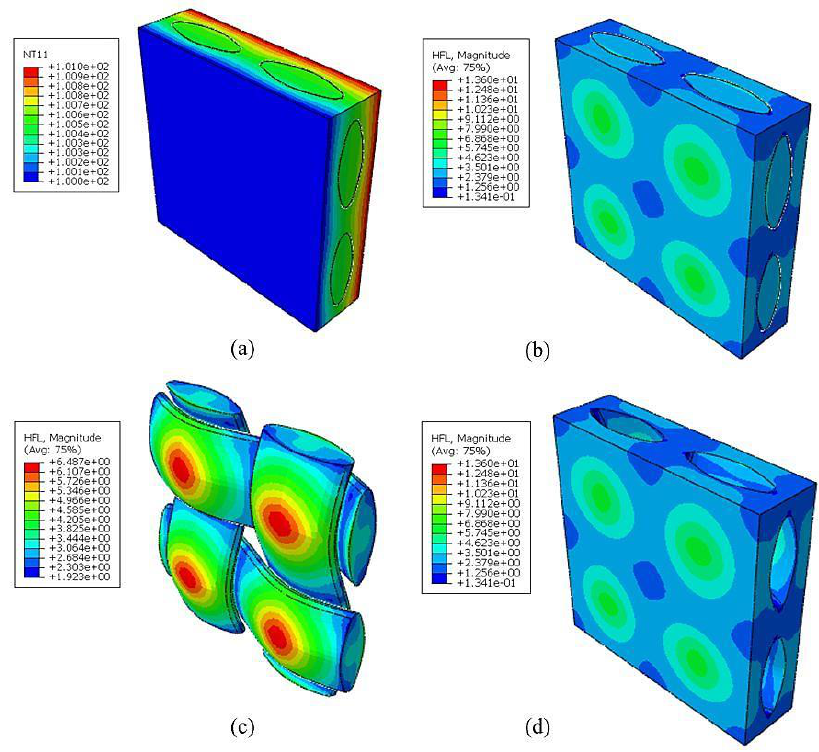
H = in the z − direction. ¯ z H j = 1 ◦ C in the z − direction.